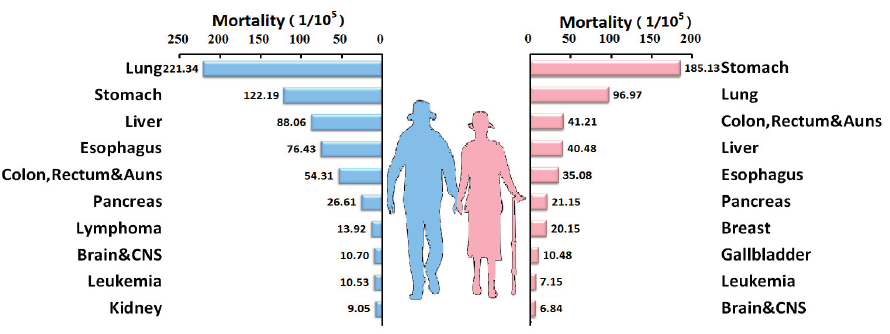
Figure 3. Top ten cancers for cancer-related mortality in the elderly population in China, 2005–2009.